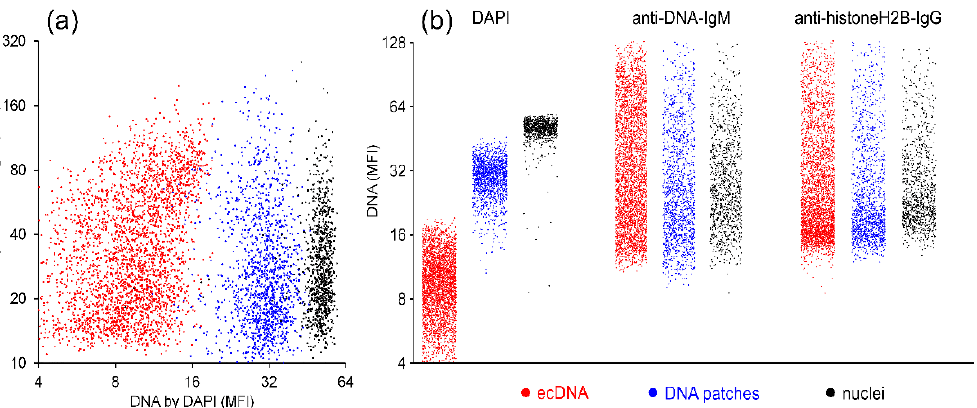
Figure 3. Morphometry revealed the advantage of anti-DNA-IgM for the detection of decondensed DNA. ( a ) DNA is indicated using the mean fluorescence intensity (MFI) of DAPI and anti-DNA as three classifications—ecDNA (red), DNA patches (blue), and nuclear (condensed) DNA (black). ( b ) Distribution of three forms of DNA with DAPI, anti-DNA-IgM, and anti-H2B-IgG. When compared to anti-DNA-IgM, DAPI displays a high fluorescence for chromatin from condensed nuclei. In addition, anti-DNA-IgM exhibits an analogous fluorescence profile of ecDNA with anti-H2B.